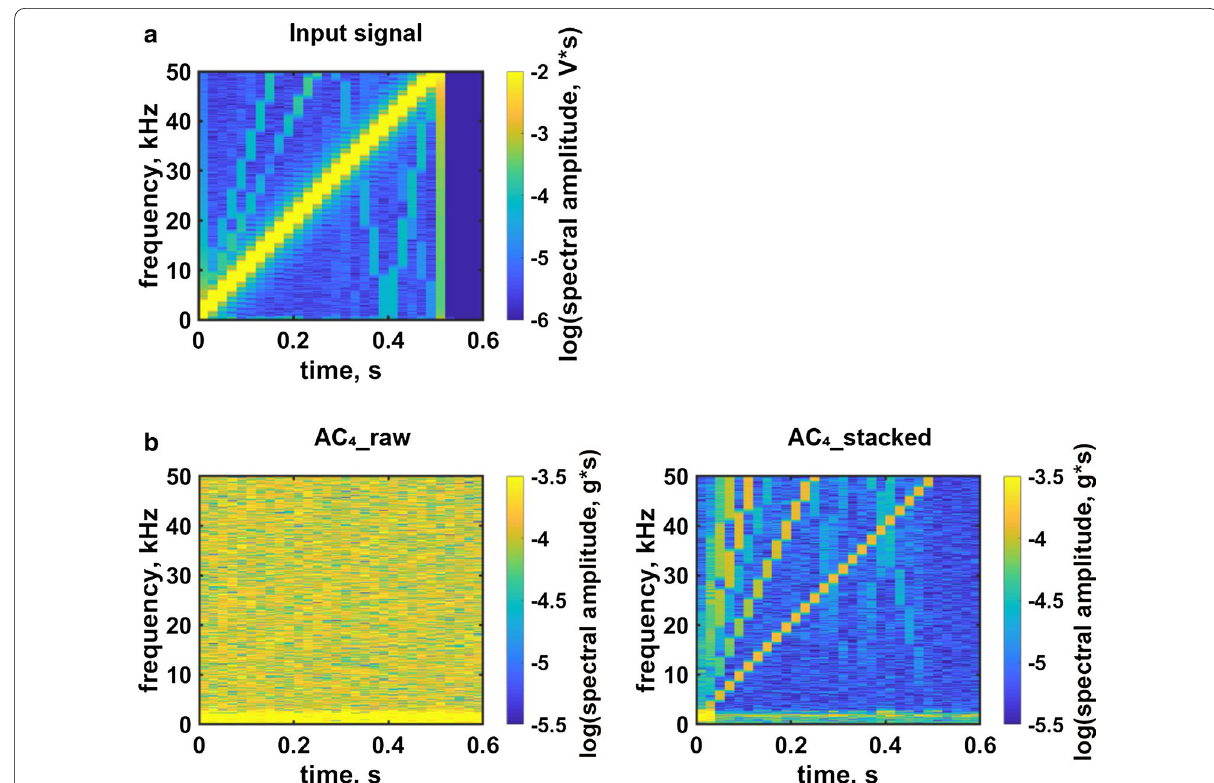
Fig. 4 a Typical spectrograms of the stacked waveform for the input signal. b Typical spectrograms of the raw waveform (left) and the stacked waveform (right) for the most distant receiver,